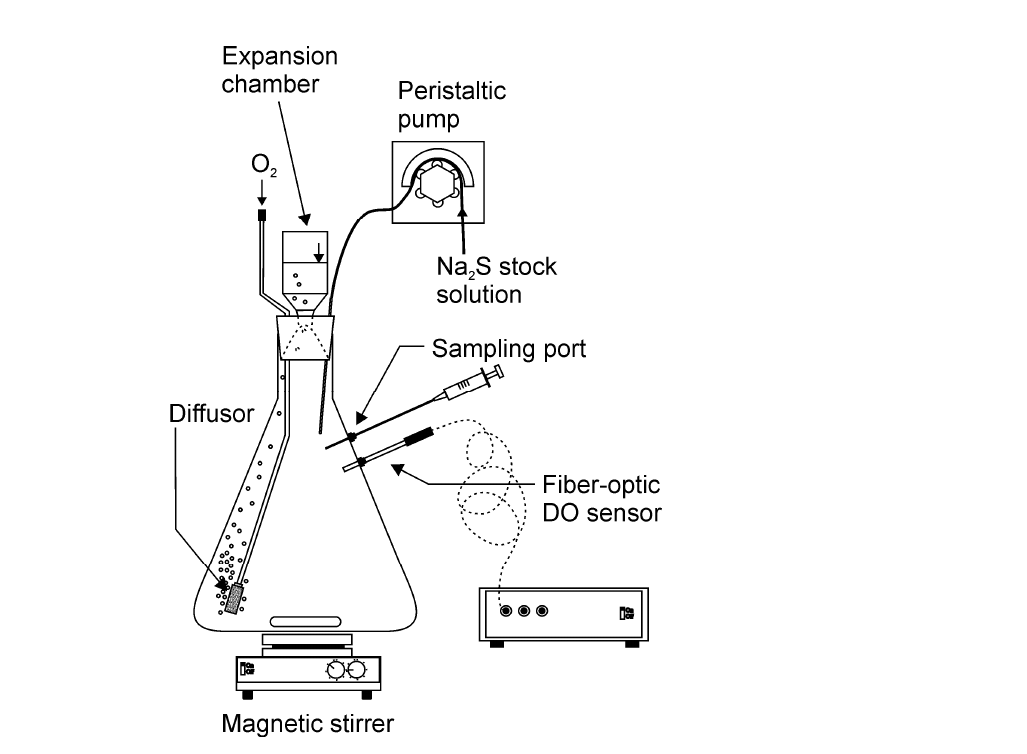
Figure 1. Illustration of the experimental setup for studying aerobic sulfide oxidation in wastewater.